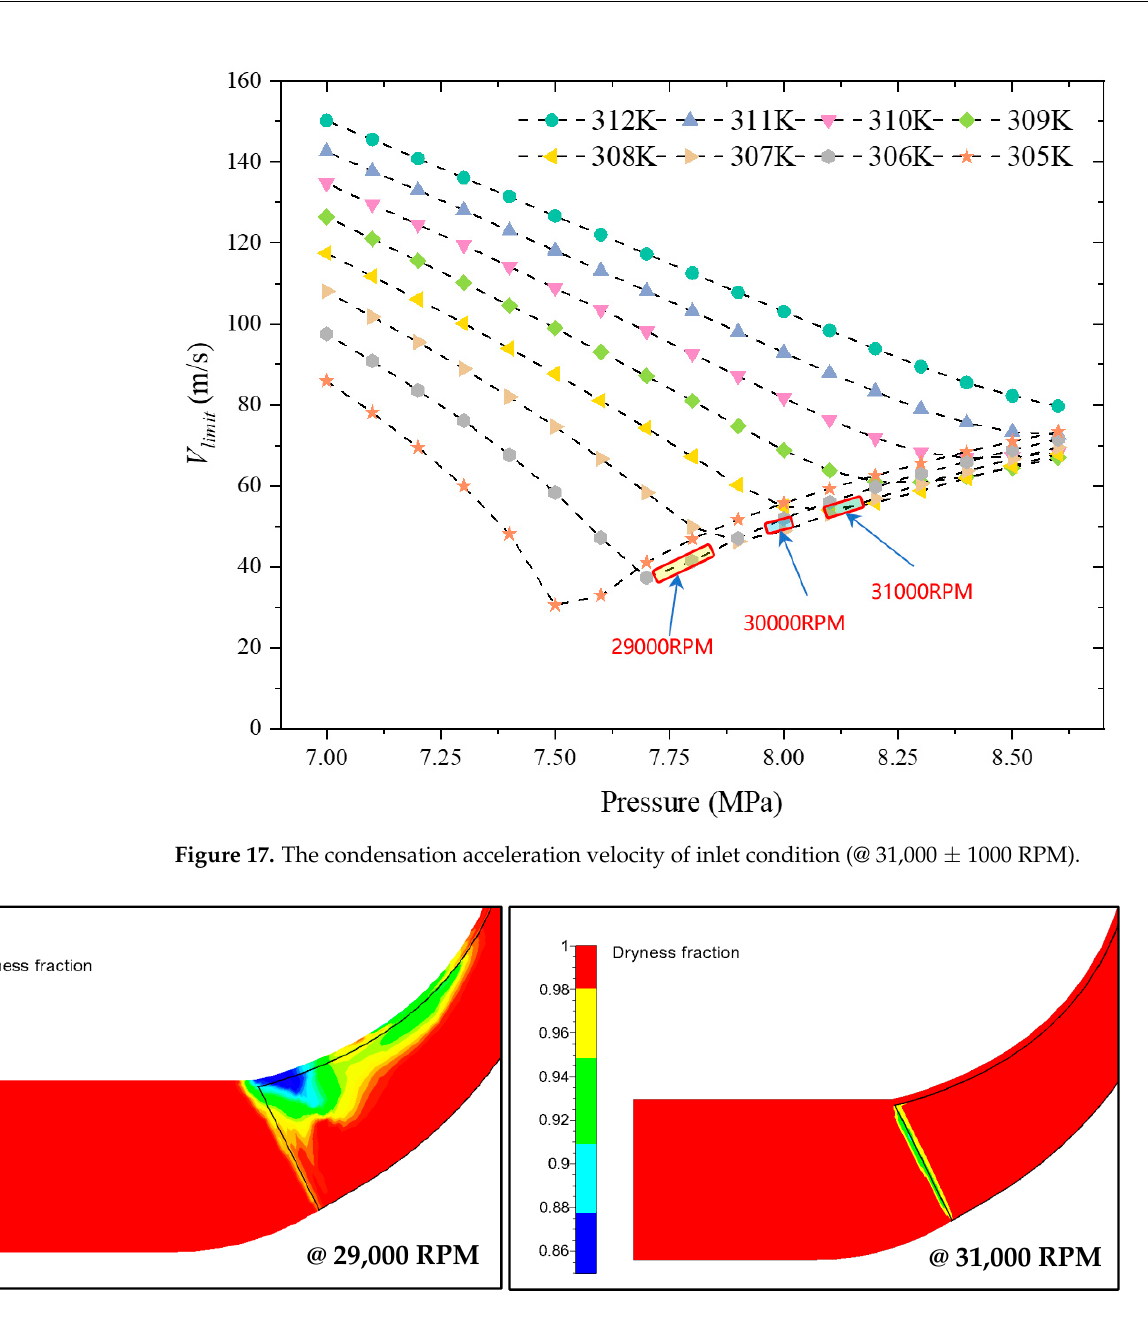
Figure 18. Dryness distribution of test point near the choke boundary and surge boundary.